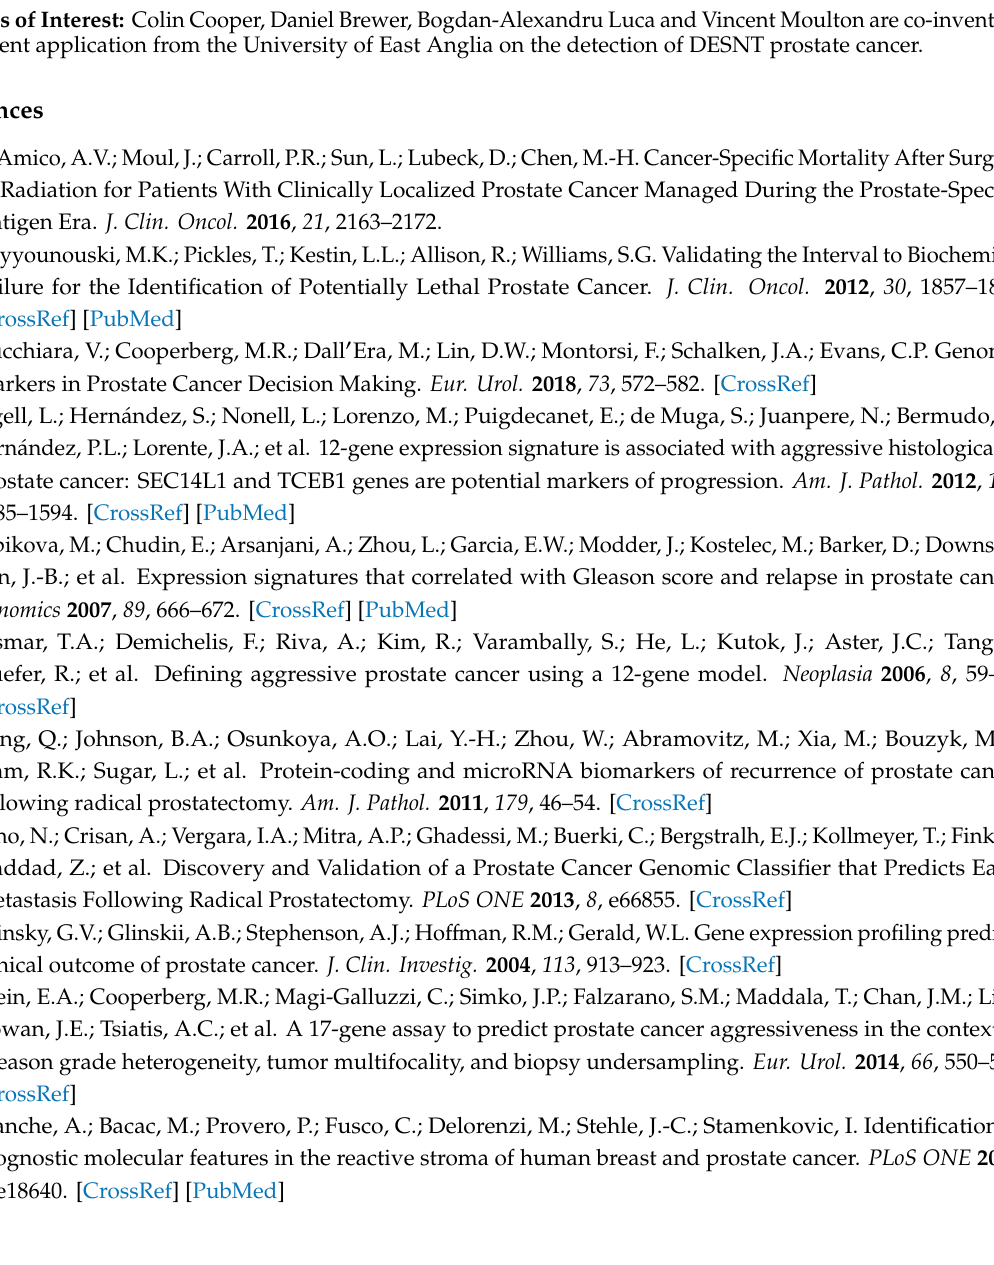
Figure S3, Data S2: Overlaps between the DESNT, OAS-DESNT, and PCS3 gene signatures, Data S3: Overlap gene signatures for the Prolaris, PCS1, and Ramos-Montoya et al. (HES6) gene signatures; Data S4: Comparisons of di ff erentially expressed genes, Data S5: Overlaps between the DESNT, OAS-DESNT, and NMF3 gene